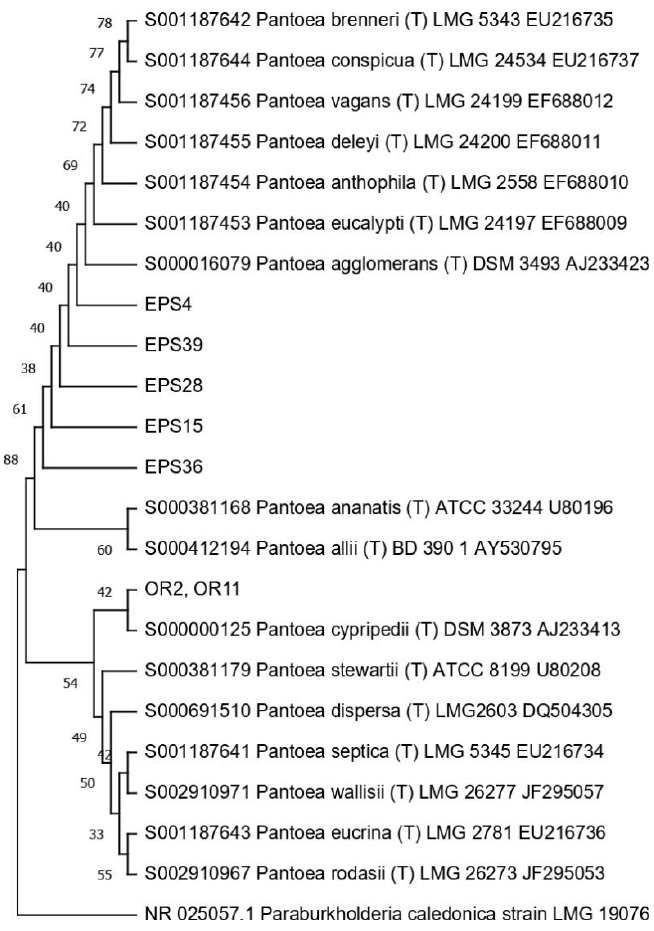
Figure 7. Phylogenetic tree for the genus Pantoea.